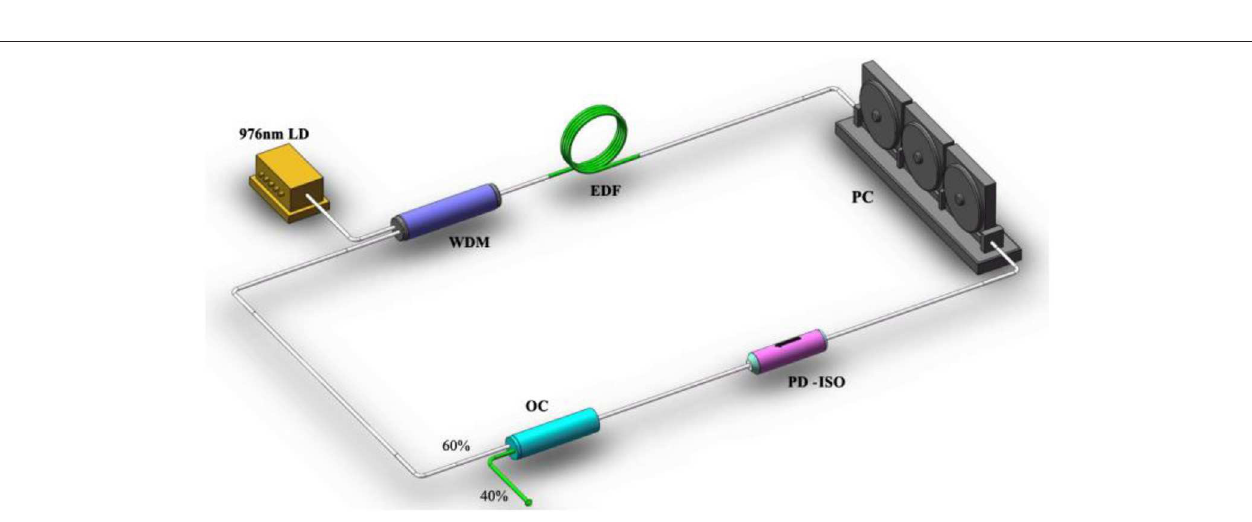
FIGURE 2 | Experimental setup of the NPR mode-locked erbium-doped fiber